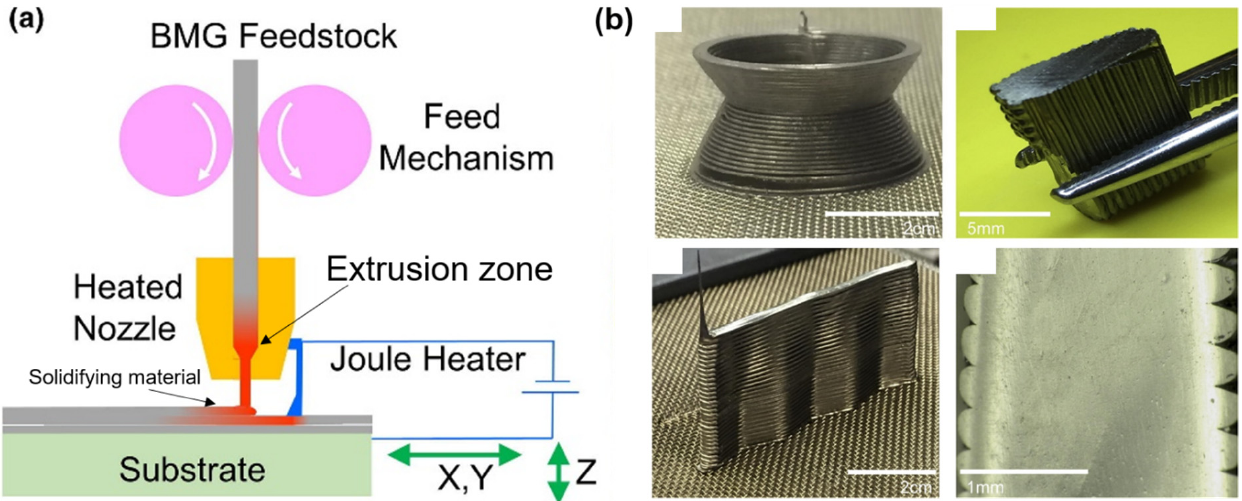
Figure 12. ( a ) Schematic illustration of the FFF process and ( b ) large Zr-based BMGs fabricated via FFF. Modified from [117], with permission from Elsevier, 2021.